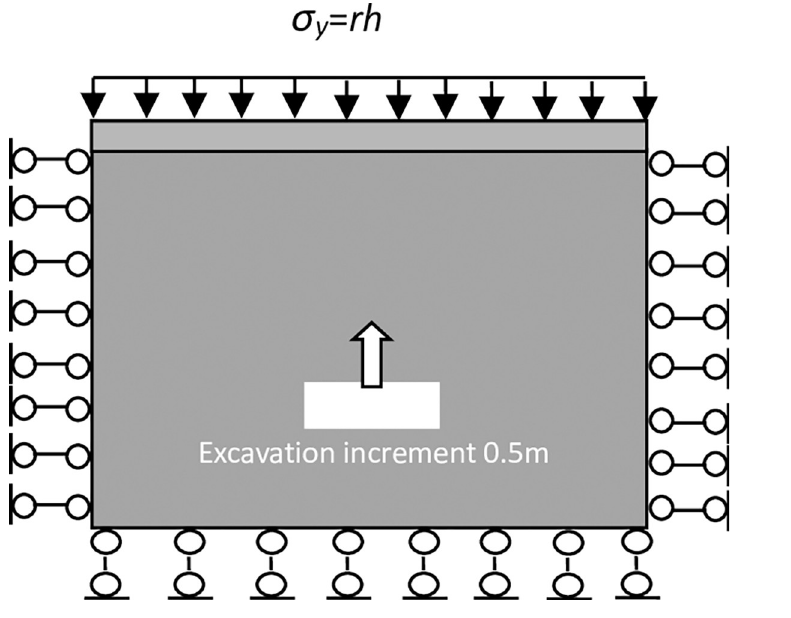
Fig 6. Layout of the